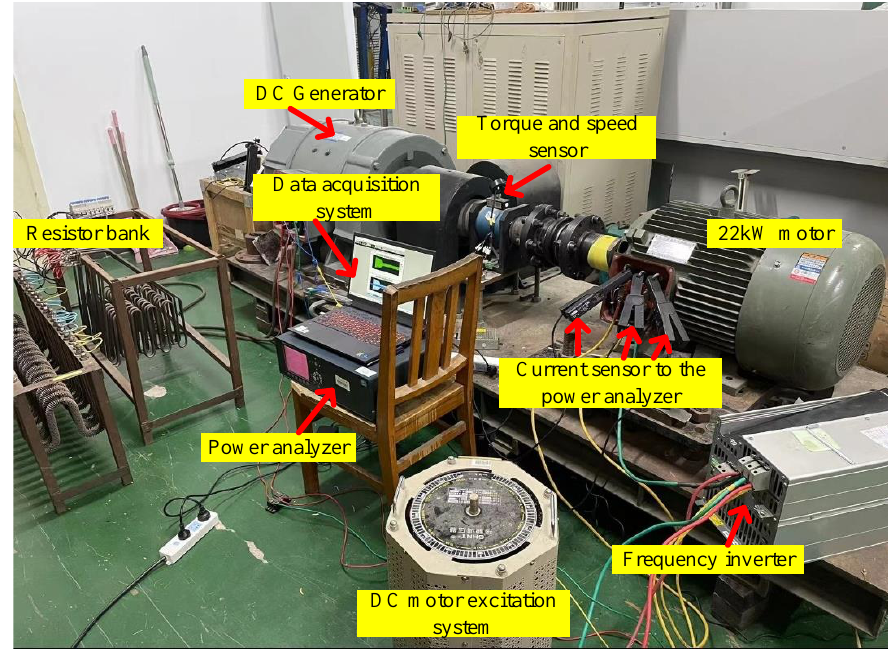
Figure 7. Test rig of 22 kW motor.